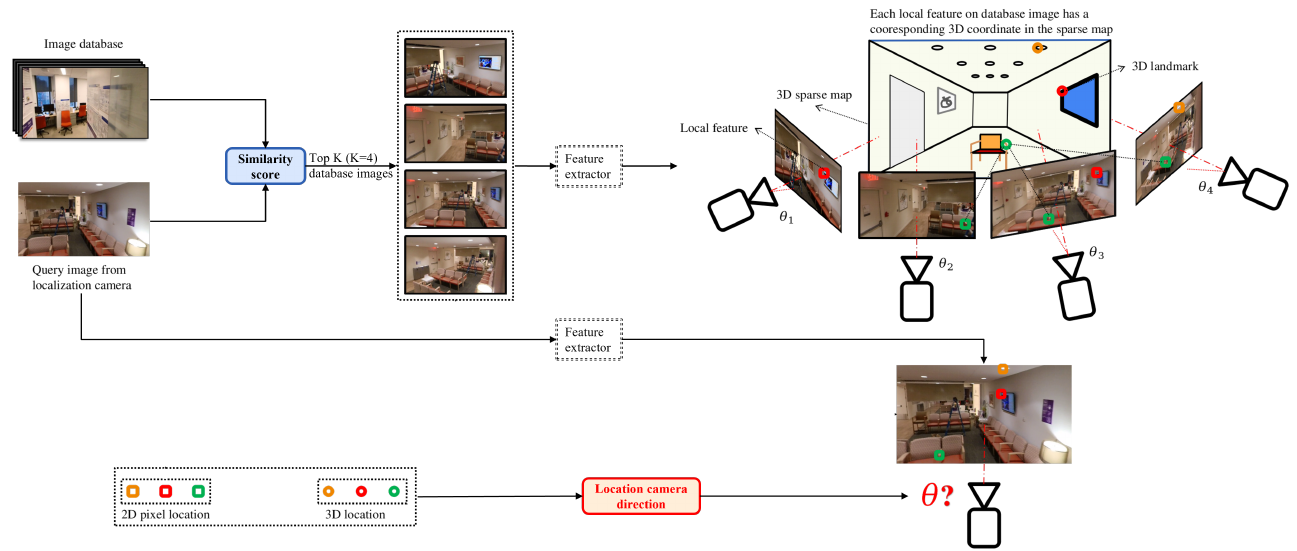
Figure 4. Hierarchical localization. Given a query image, the K reference images with the highest matching scores (Figure 3) are retrieved as candidate images. Using SuperPoint and SuperGlue, similar local features between the query image and candidate images can be identified. Each local feature on the candidate image has a 3D location in the sparse map. Thus, a set of 2D–3D point correspondences between the query image and the sparse map are found and the direction of the camera is determined using the PnP